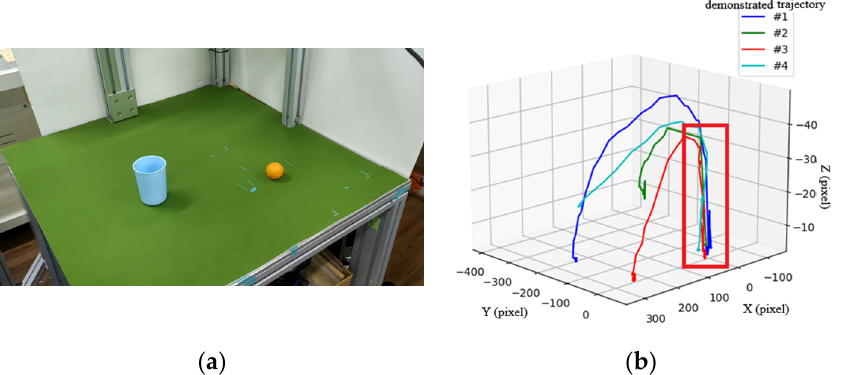
Figure 11. Scenario 2: “place a ball into a cup”. ( a ) Experimental environment; ( b ) relative trajectory (type-3) from the cup to the ball through 4 demonstrations to induce a key path indicated by a red box.